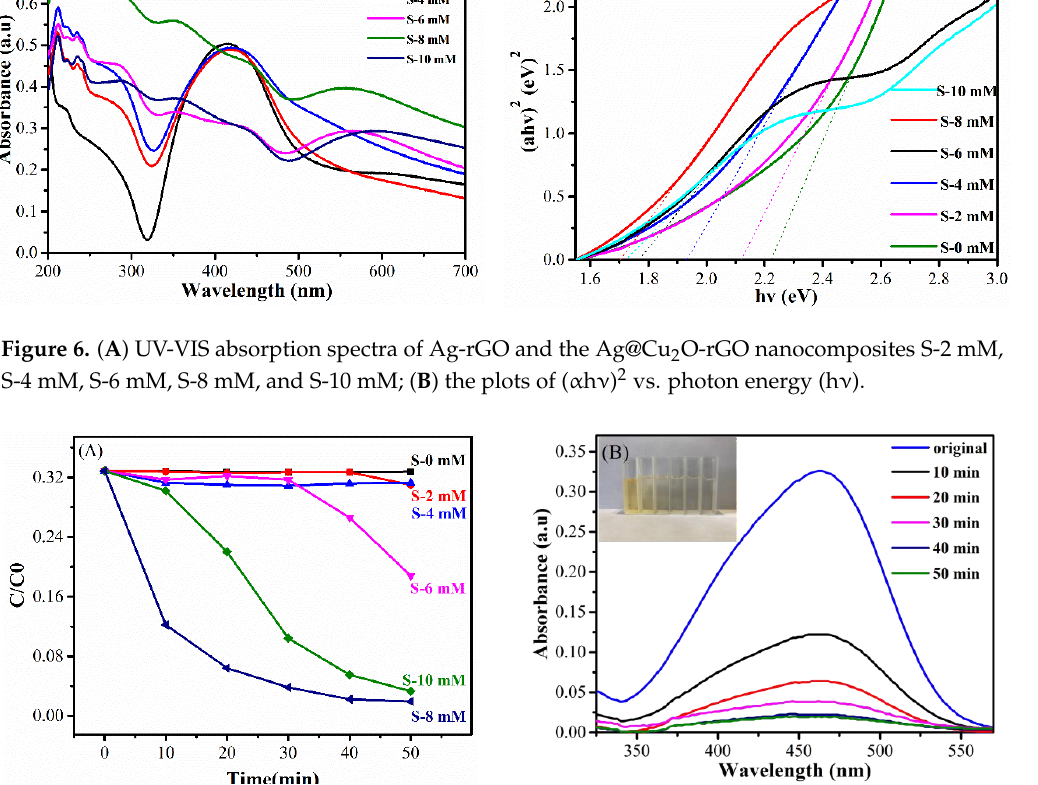
Figure 7. ( A ) Photocatalytic degradation of Methyl Orange (MO) (4 mg/L) under